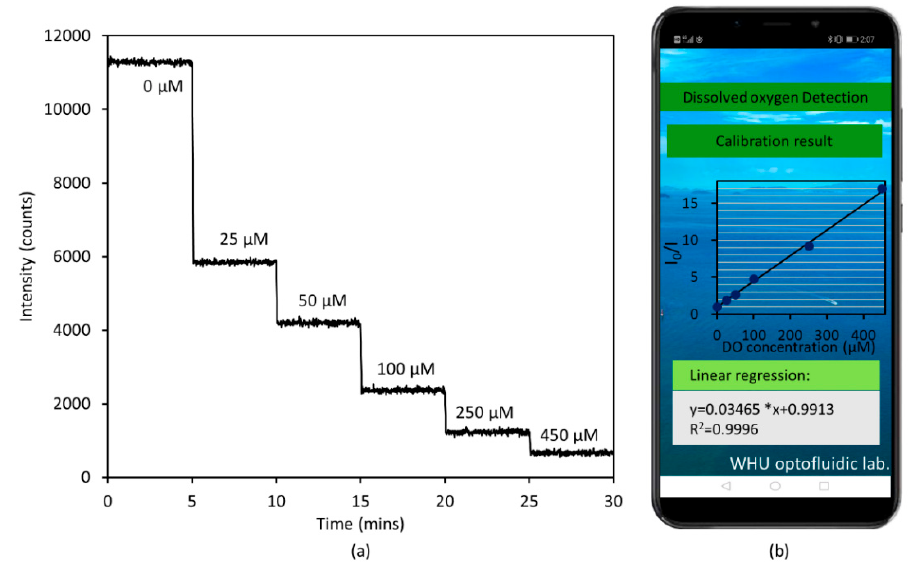
Figure 4. ( a ) Response of the intelligent DO sensor to different oxygen concentrations. ( b ) The Stern–Volmer plot of the intelligent sensor.